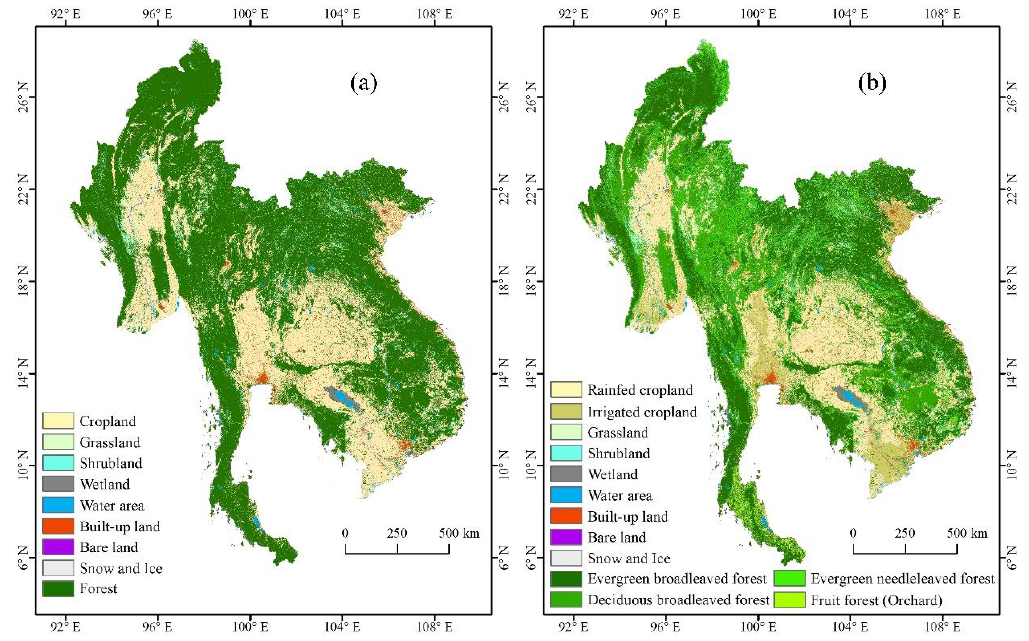
Figure 3. ( a ) The first-level types fusion result; ( b ) the fusion result containing the second-level types.